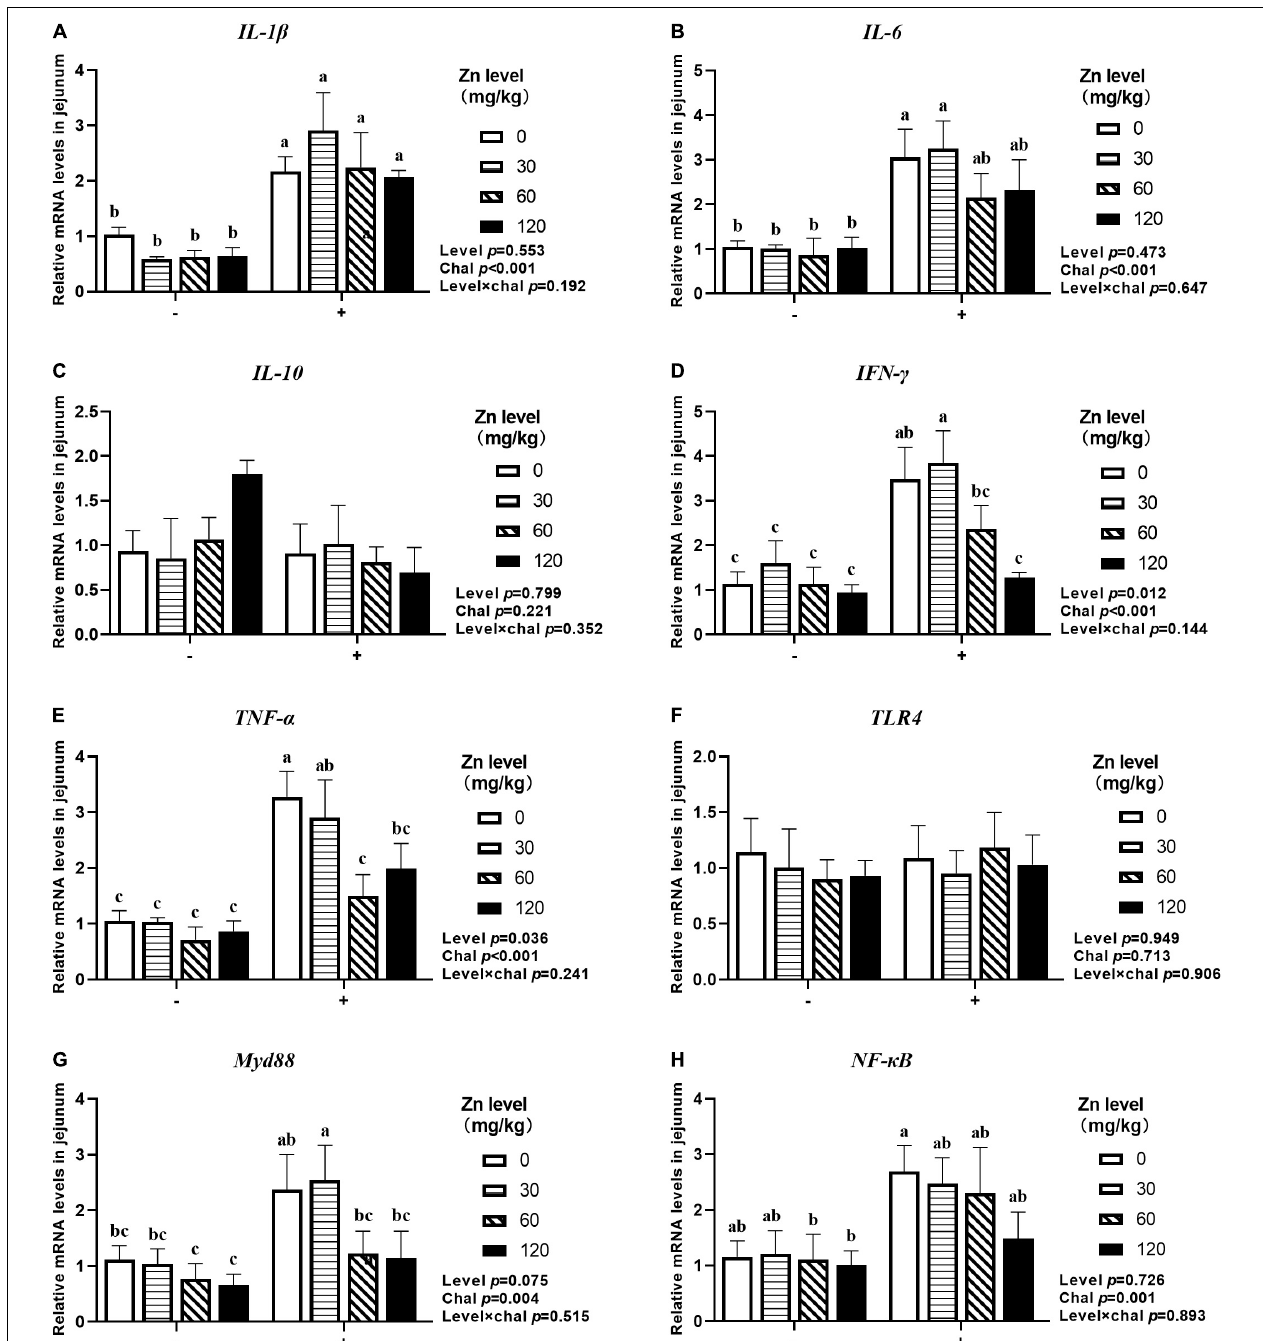
FIGURE 6 | Effect of dietary Zn–Met levels on the mRNA expression of inflammatory cytokines IL-1 β (A) , IL-6 (B) , IL-10 (C) , IFN- γ (D) , TNF- α (E) and TLR4 signaling pathway related gene (F–H) in jejunum of meat duck challenged with APEC (8 DPI). Bars with different letters are statistically significant ( P < 0.05). Results are expressed as mean ± SEM ( n =